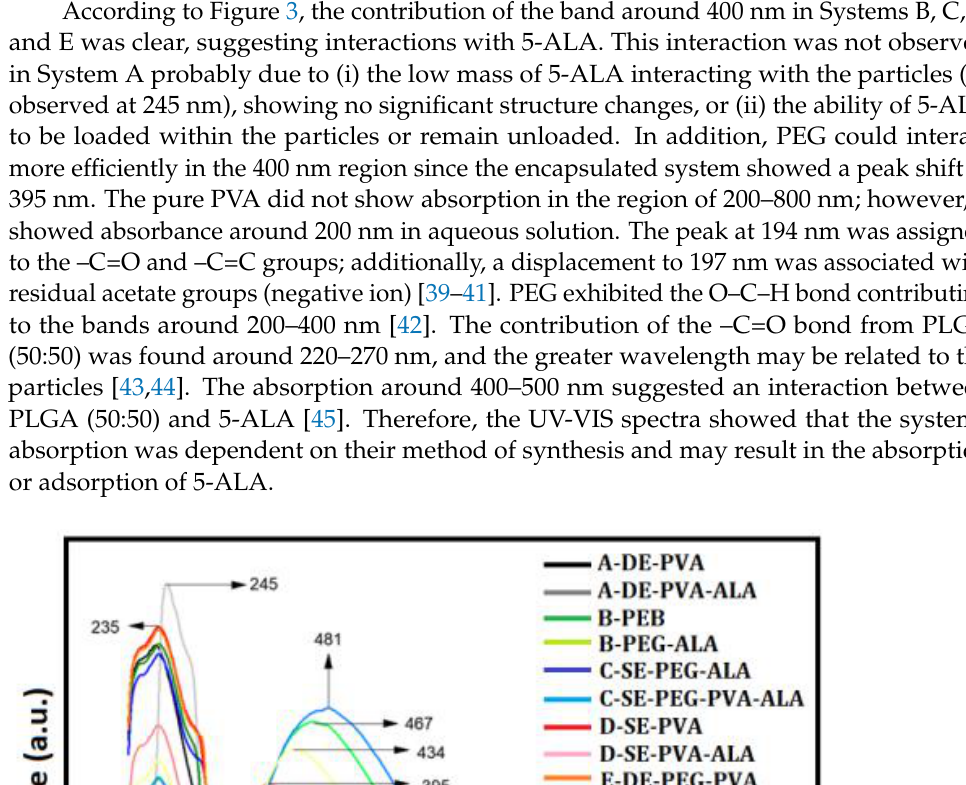
Table 3. Hydrodynamic size comparison of System A (A – DE – PVA and A – DE – PVA – ALA), Sys- tem C (C – SE – PEG – PVA and C – SE – PEG – PVA – ALA), system D (D – SE – PVA and D – SE – PVA – ALA) and System E (E – DE – PEG – PVA and E – DE – PEG – PVA – ALA) obtained by NTA and DLS